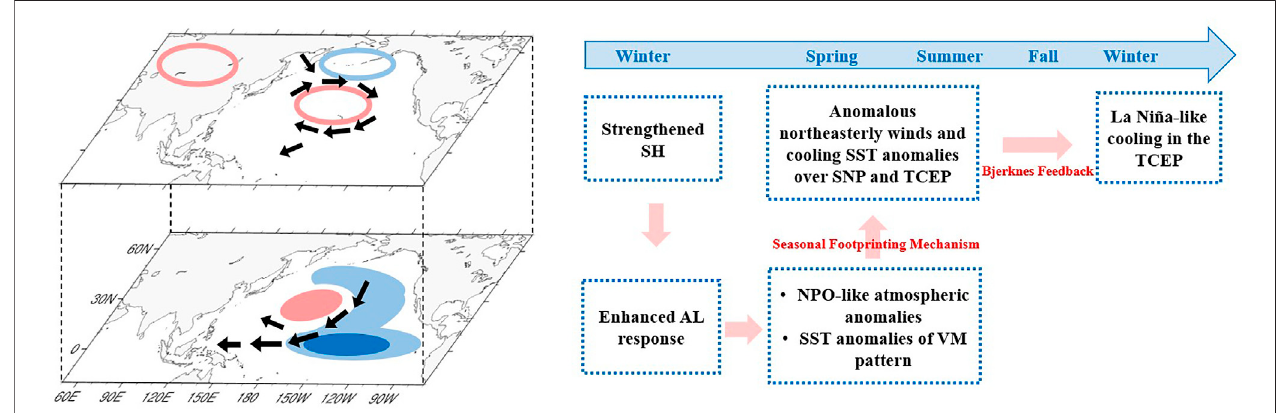
FIGURE 9 | A mechanism diagram showing the processes linking the SH to the subsequent winter ENSO. Red (blue) circles indicate positive (negative) SLP anomalies. Red (blue) shading denotes positive (negative) SST anomalies. Black arrows are surface wind anomalies. SNP and TCEP denote subtropical North Paci fi c and tropical central-eastern Paci fi c,